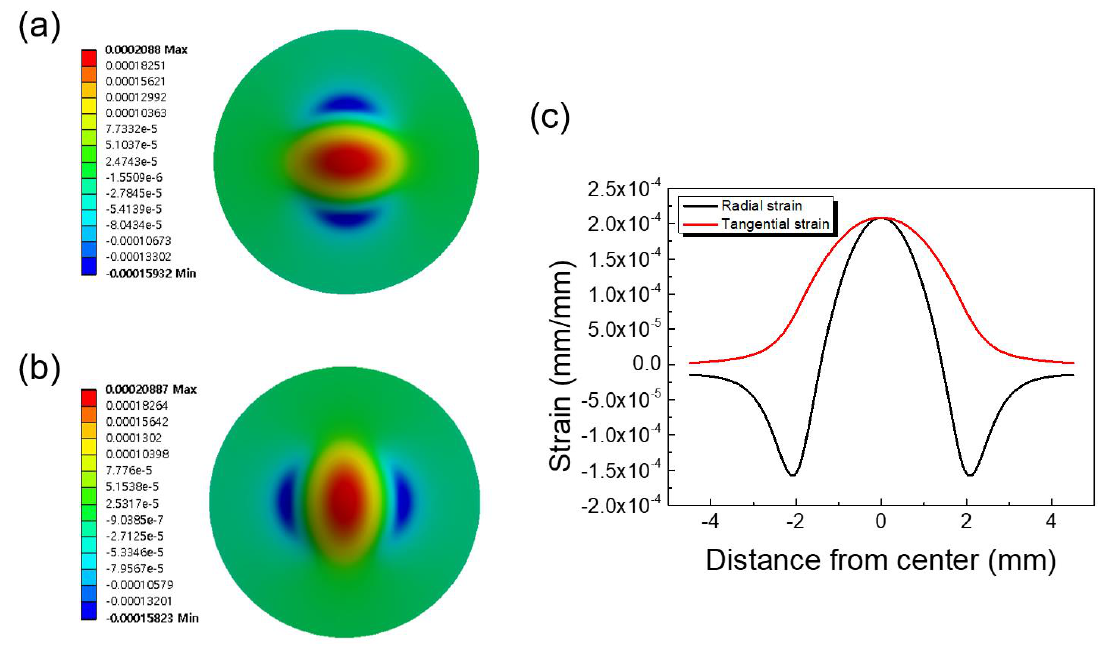
Figure 6. Strain distribution on the surface of a stainless-steel circular diaphragm. Color maps of ( a ) tangential and ( b ) radial strains. ( c ) Two-dimensional plot of tangential and radial strains.